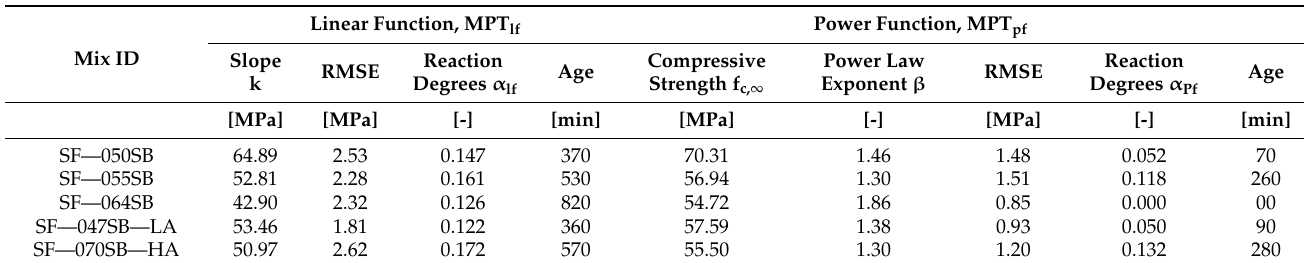
Table 8. Parameters of the fitting function, Equations (5) and (6), for the compressive strength evolution as a function of the degree of